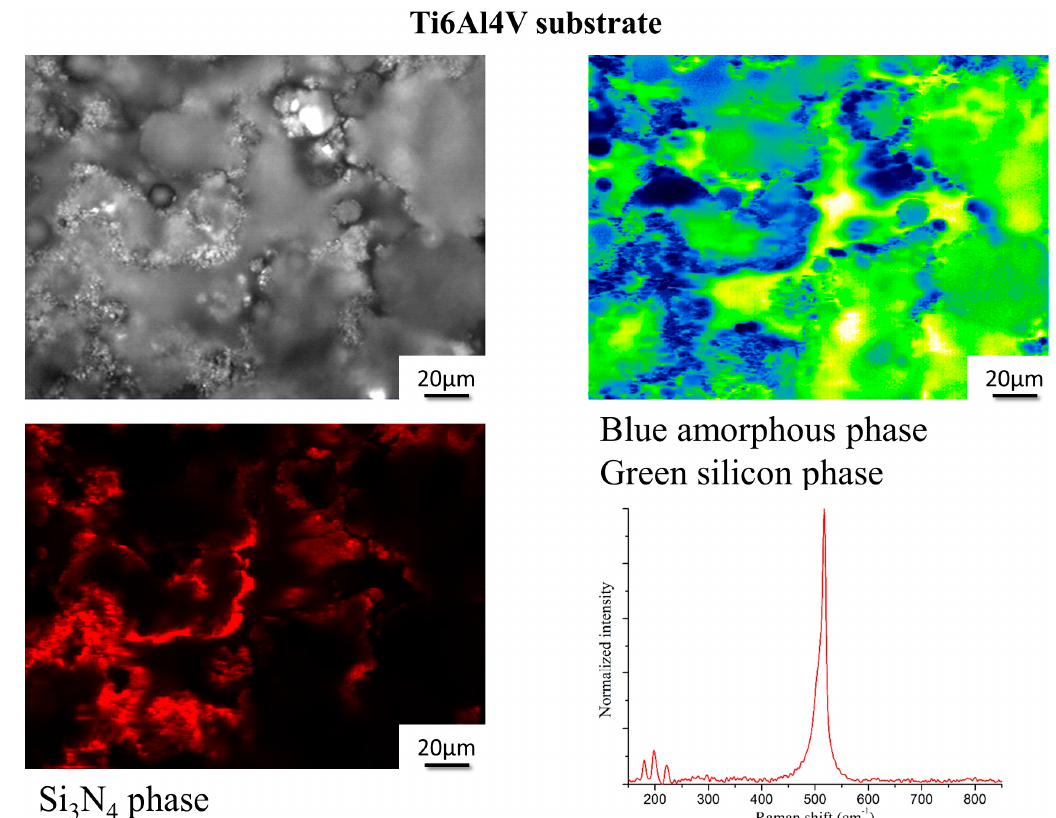
Figure 4. Raman imaging maps and Raman spectra of coated Ti6Al4V substrate.